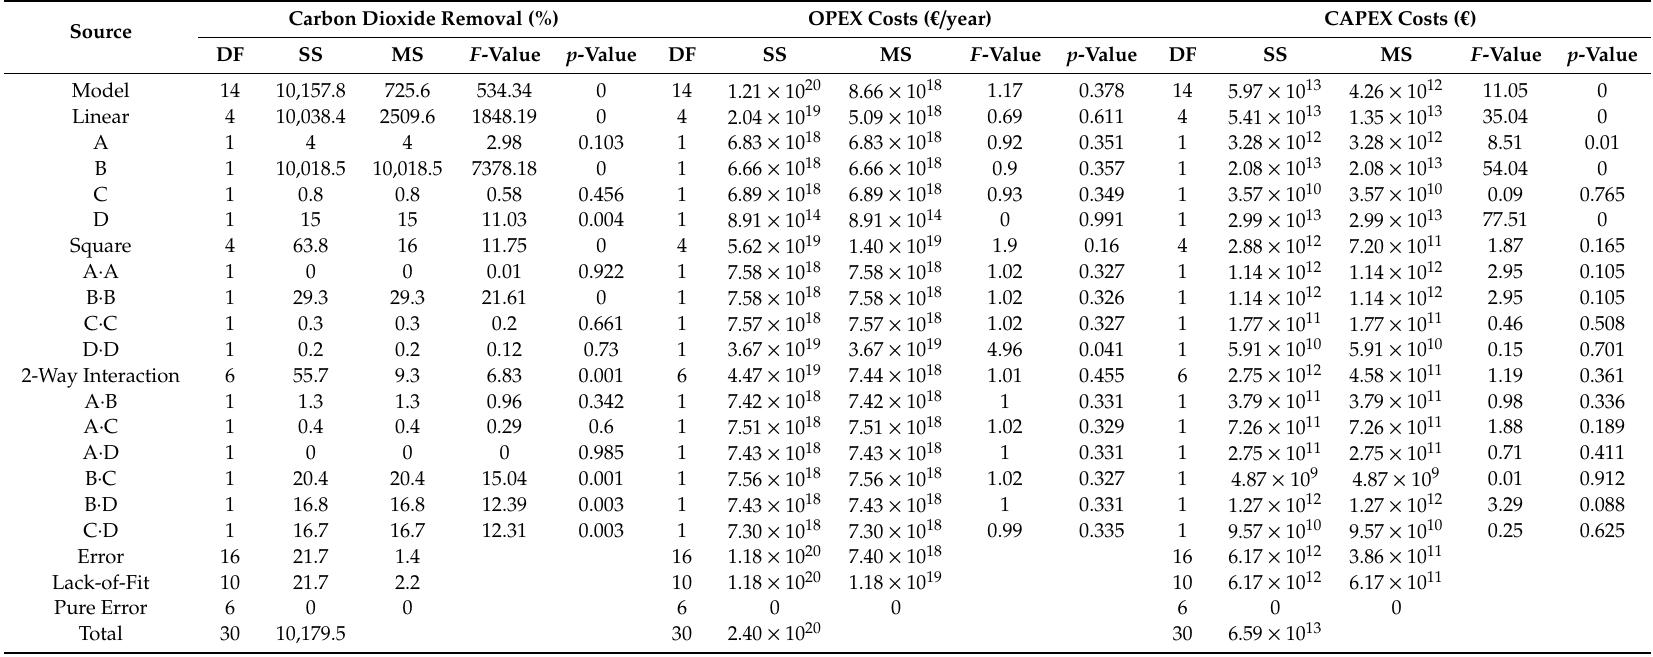
Table 8. Results of ANOVA analysis for the considered